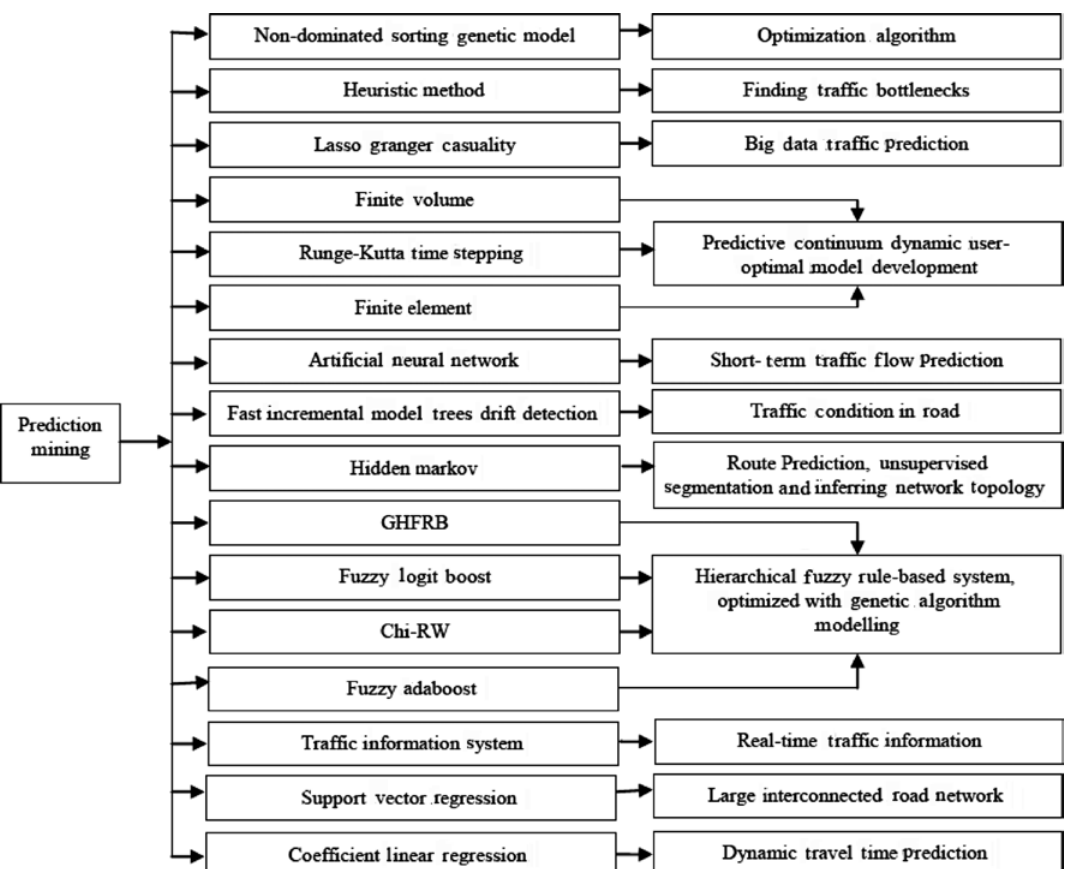
Figure 5: List of Predictive Methods Used in Intelligent Transportation System.